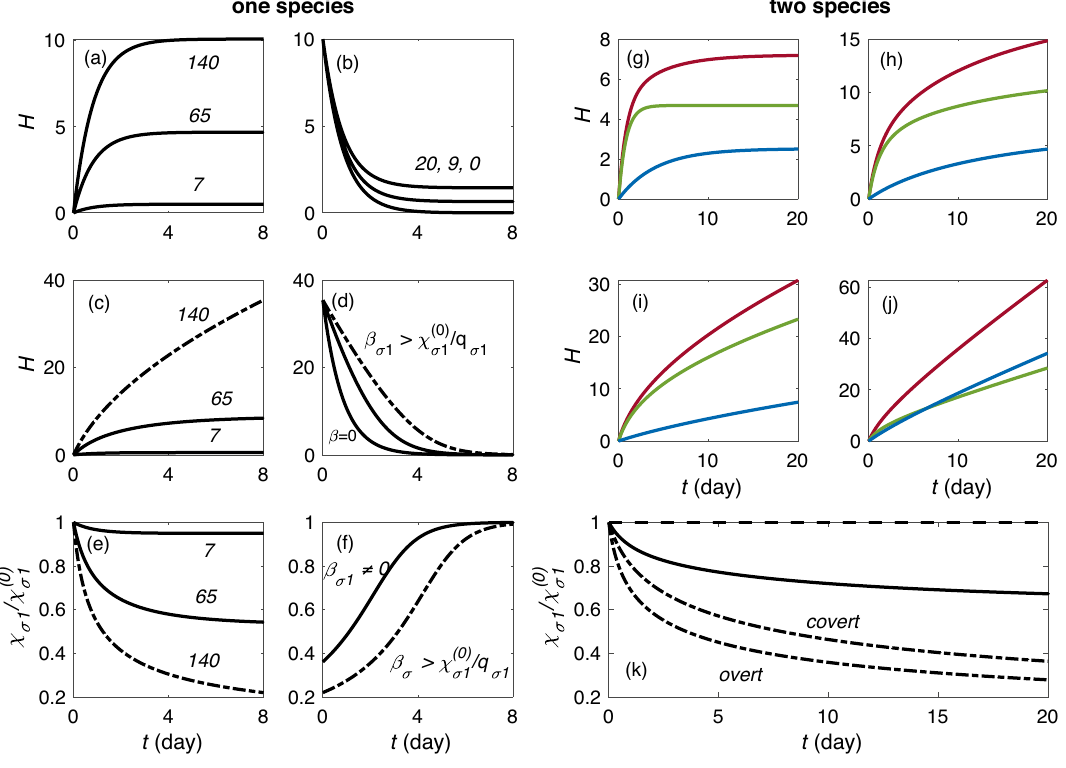
Figure 2. Homeostatic dynamics with one and two species in a fixed arousal state with and without runaway. One species dynamics are shown in ( a )–( f ). ( a ) Rising H 1 and β σ 1 = 0 for production rates q σ 1 = 7 × 10 − 6 , 65 × 10 − 6 , and 140 × 10 − 6 s − 1 , as labeled in units of 10 − 6 . ( b ) Falling H 1 and β σ 1 = 0 for q σ 1 = 20 × 10 − 6 , 9 × 10 − 6 , and 0 s − 1 from top to bottom. ( c ) Rising H 1 and β σ 1 = 0.1 for the same values of q σ 1 as in ( a ), with runaway case indicated with dot-dashed lines. ( d ) Falling H 1 for β σ 1 = 0.05, 0.1, 0 , from top to bottom. ( e ) Normalized clearance rate vs. t for the cases in ( c ), with runaway case indicated with dot- dashed lines. ( f ) Normalized clearance rate vs. t for the cases in ( d ); for β σ 1 = 0 this ratio is 1 throughout so it is not shown. Homeostatic rise using two-species drive during wake is shown in ( g )–( j ). Fast clearance H 1 is shown in green, slow clearance H 2 in blue, and total H in red. ( g ) State with β 1 = β 2 = 0 and H 1 and H 2 starting from zero. ( h ) Same as in ( g ) but β 1 = 0.05 and β 2 = 0.15 . ( i ) Overt runaway state with β 1 = 0.15 and β 2 = 0.15 . ( j ) Covert runaway. ( k ) Clearance dynamics for two species with β 1 = 0.15 and β 2 = 0.15 in dot dashed line, β 1 = 0.05 and β 2 = 0.15 in solid line, and β 1 = β 2 = 0 in dashed line. In the covert runaway case